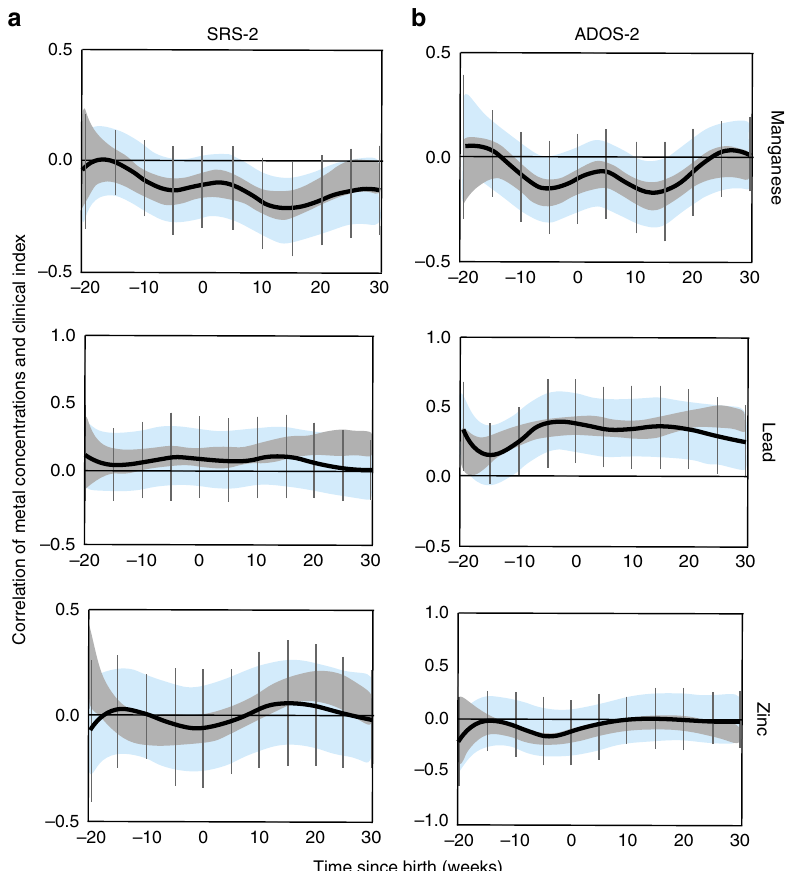
Figure 6 | Association of elemental concentrations with measures of autism traits and clinical severity. ( a ) Correlation of manganese, lead and zinc with Social Responsiveness Scale-2 (SRS-2) at different developmental time points. ( b ) The correlation of these elements with Autism Diagnostic Observation Schedule-2 (ADOS-2). Data are shown as 95% bands unadjusted (grey band) and adjusted (blue band) for intra-twin correlations. Grey vertical lines are Holm–Bonferroni corrected family-wise 95% CIs for 11 comparisons (every fifth week). Values above zero represent positive correlation between metal uptake and clinical index score. A critical window is defined as an area of the intra-twin adjusted correlation (blue band) that does not include zero. Models are adjusted for gender, gestational age and birth